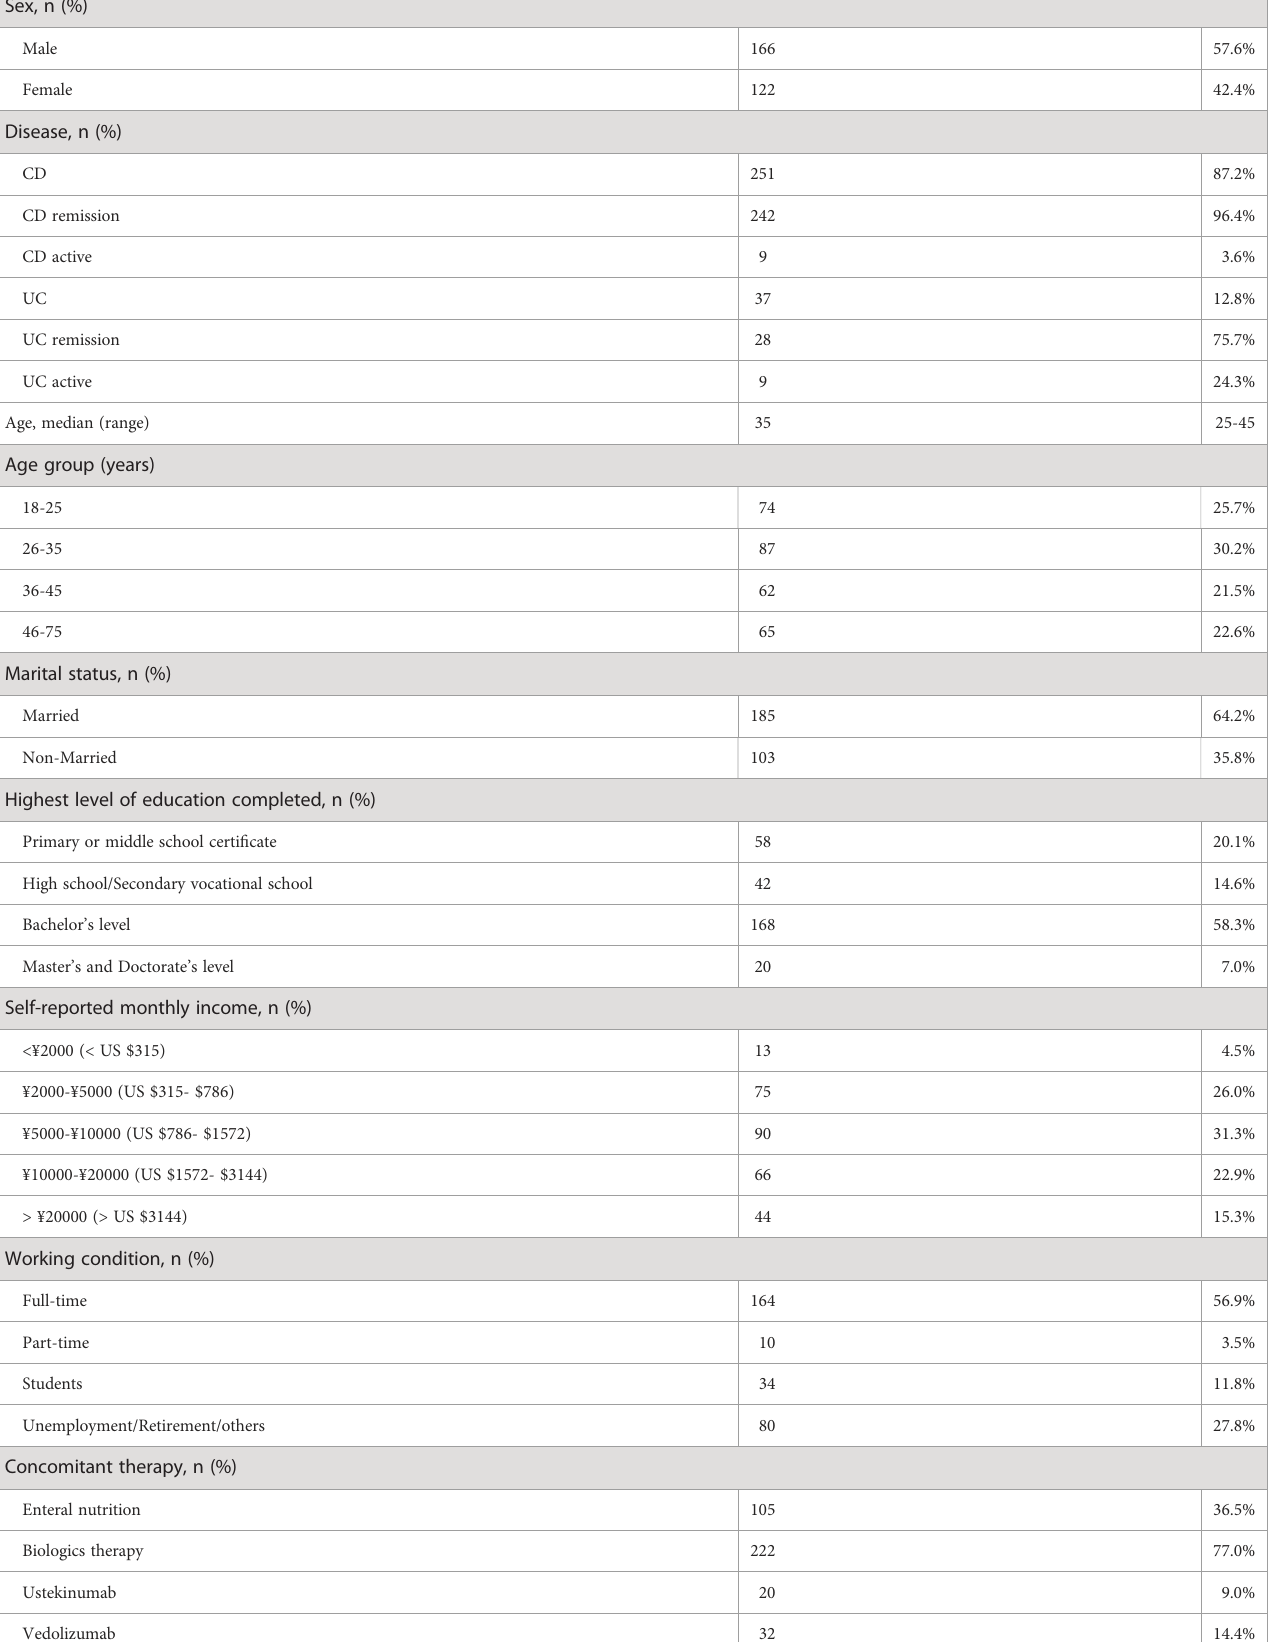
TABLE 1 Patient characteristics